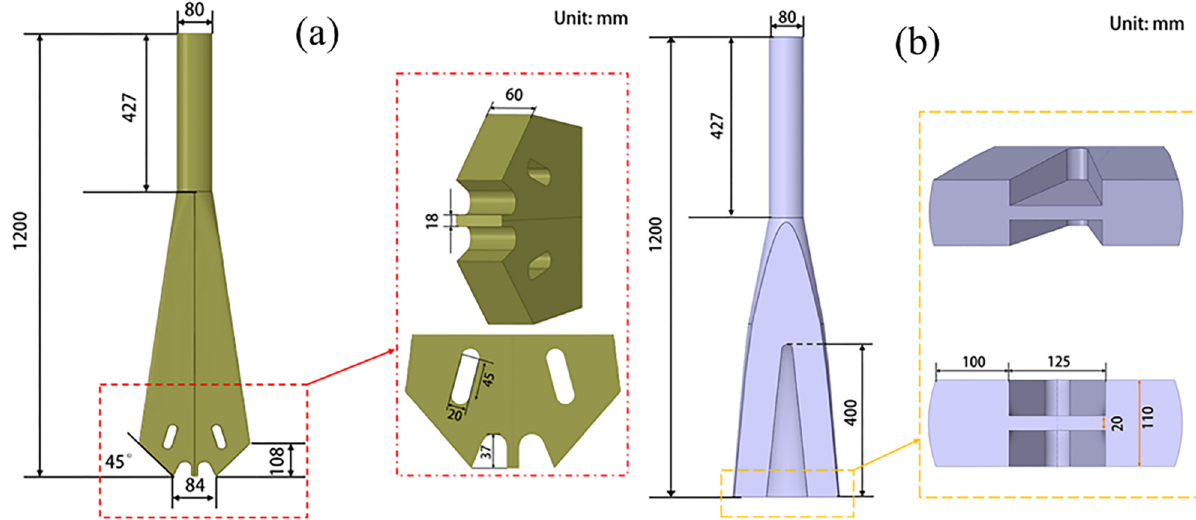
Figure 2: SEN shape: ( a ) FHSEN and ( b )